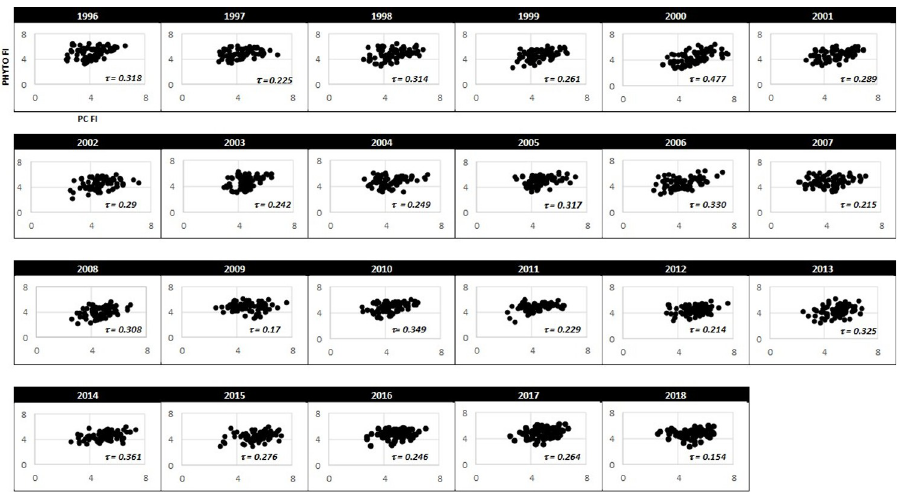
Fig 3. Scatterplots of PHYTO FI vs PC FI showing the Kendall’s Tau correlation value ( τ , p-value < 0.05) for each year of the study.